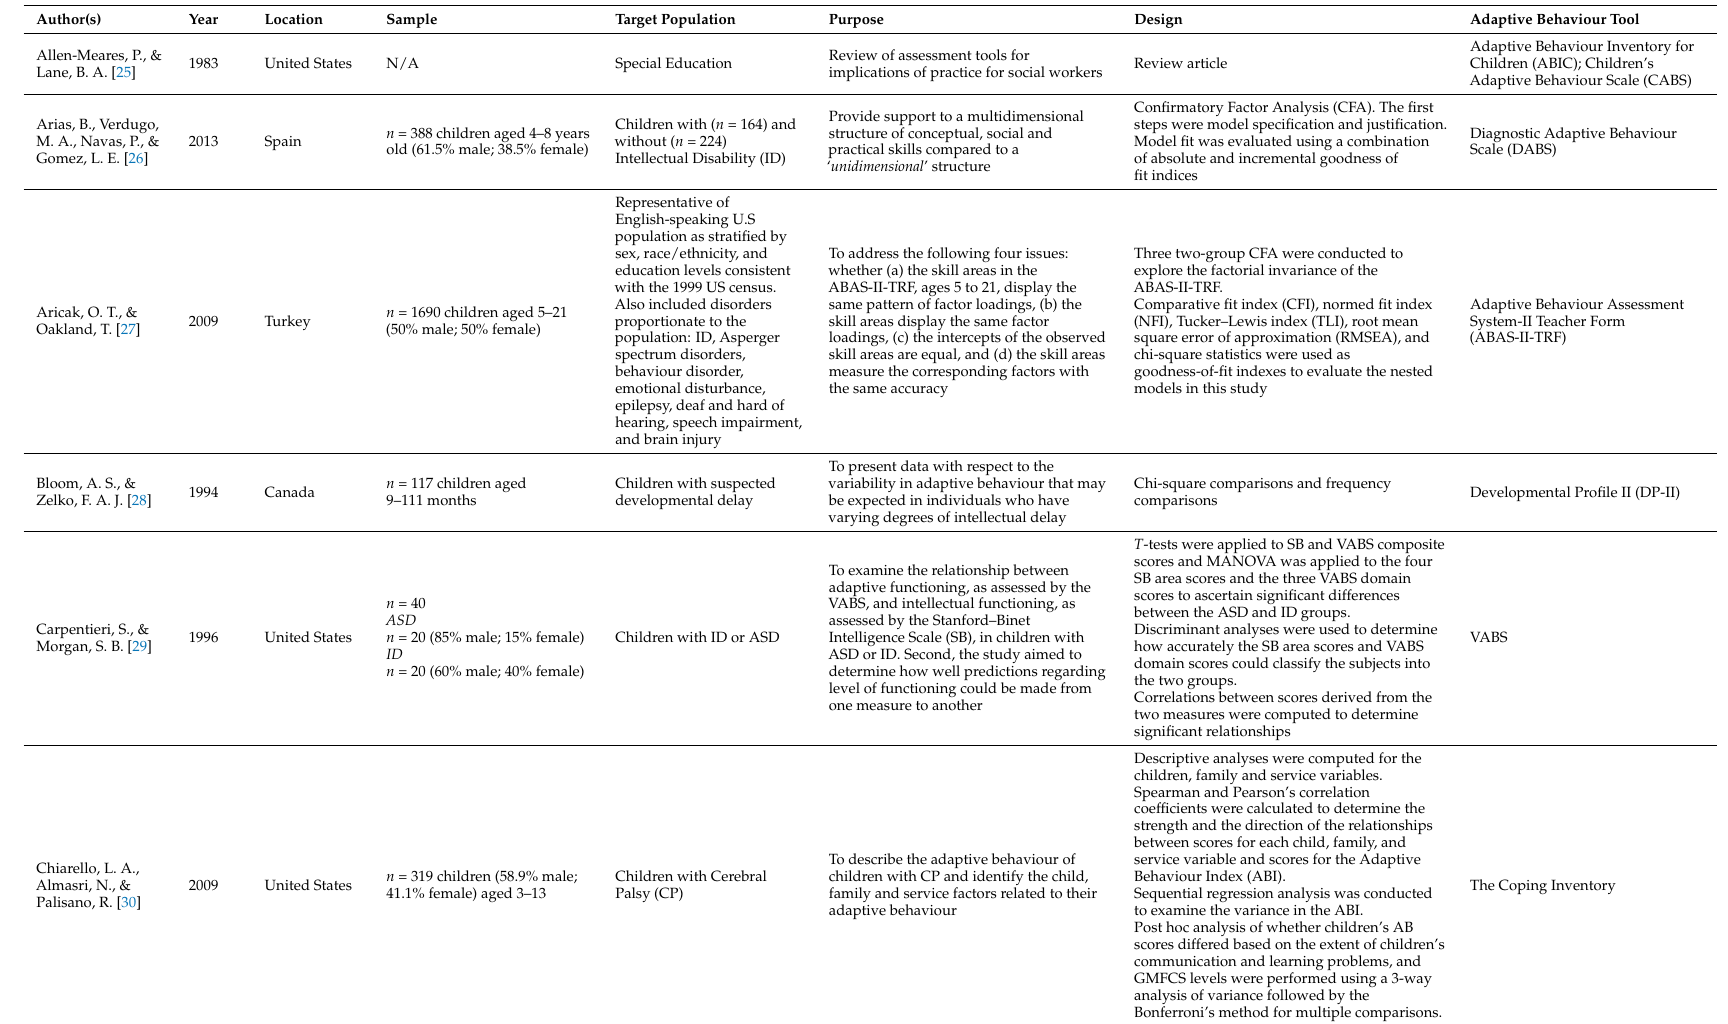
Table 3. Summary characteristics of included